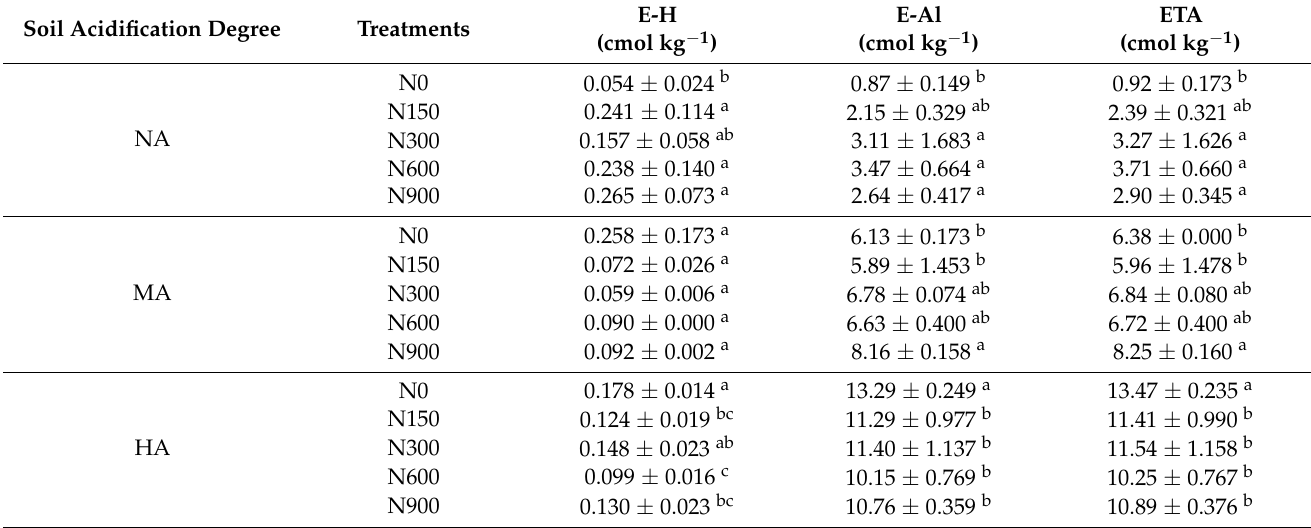
Table 4. Effects of N application rates on soil exchangeable acids at tea plantations with different degrees of acidification.